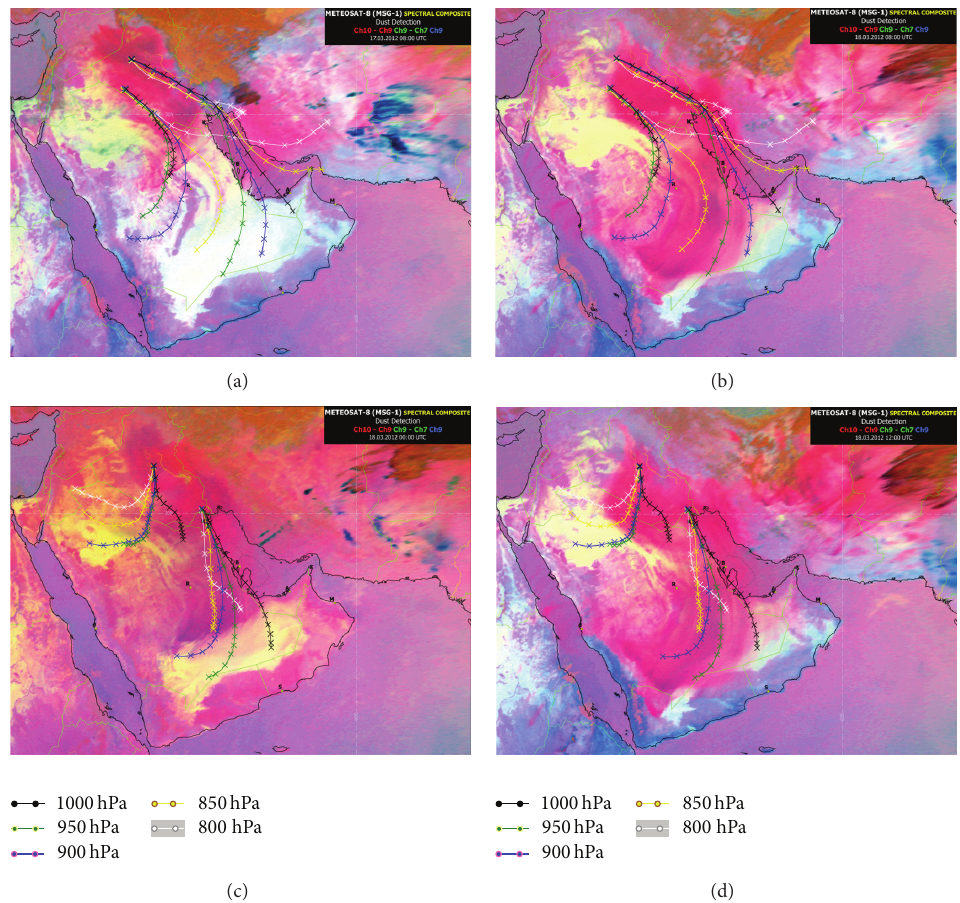
Figure 4: System out for the dust storm event over Tigris and Euphrates rivers basin starting from March 17, 2012.